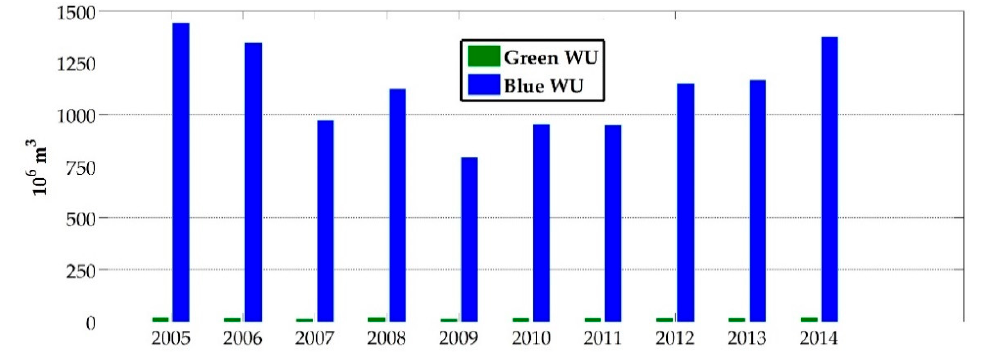
Figure 9. The variation of green and blue water use (WU) in the province from 2005 to 2014.